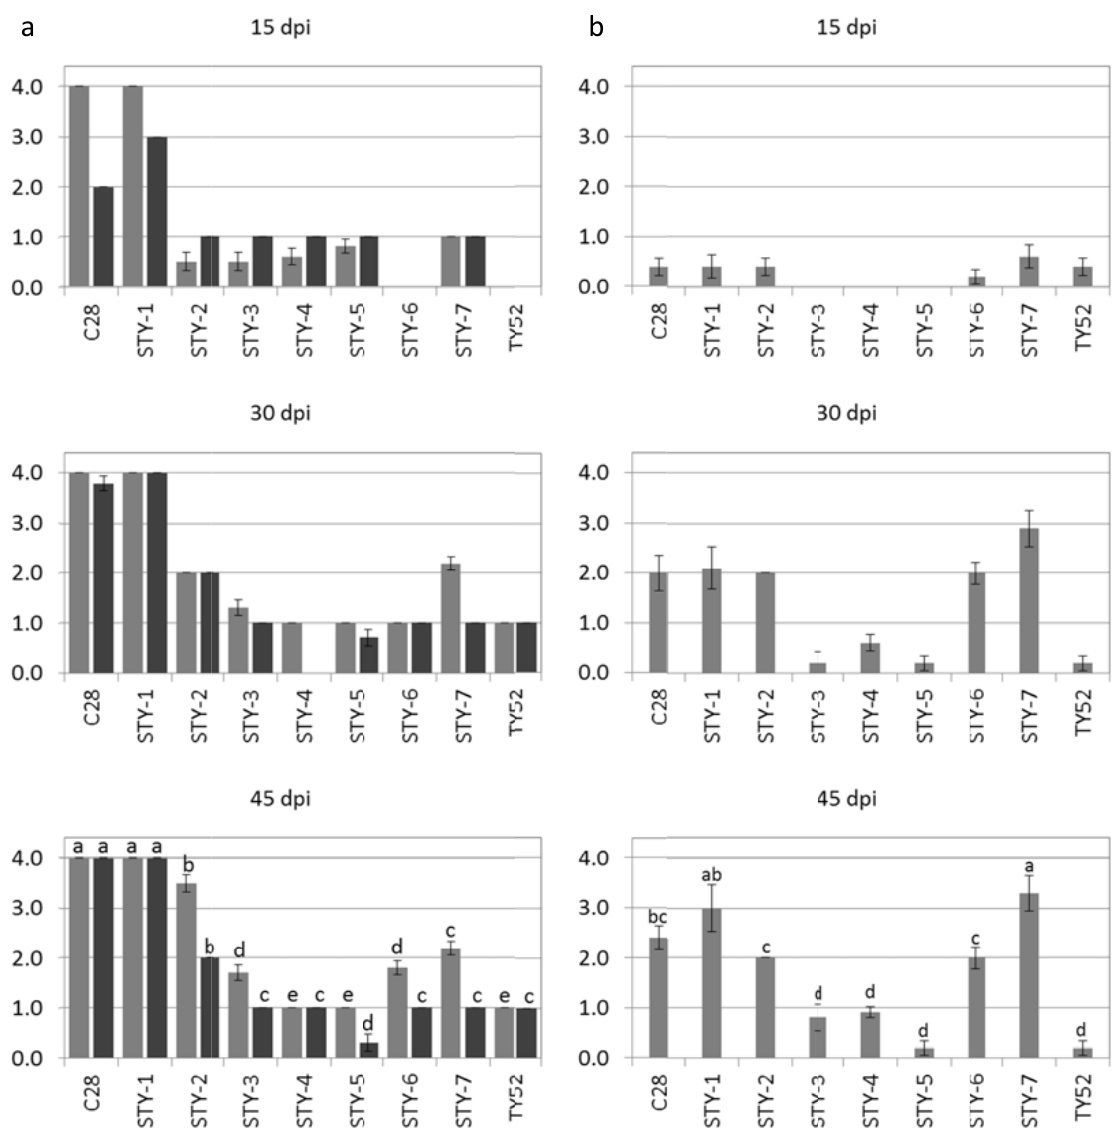
Figure 3. Average symptom score (± standard error) at each evaluation date (dpi: days post inoculation) in the STY lines, the susceptible control ‘Campbell 28’ (C28) and the resistant control ‘TY52’. Symptom scores were evaluated using a scale from 0 (symptomless) to 4 (severe symptoms). At 45 dpi, different letters for genotypes in the same assay indicate statistically significant differences (LSD, P <0.05). A) Assays 5 (light grey) and 6 (dark grey). B) Assay